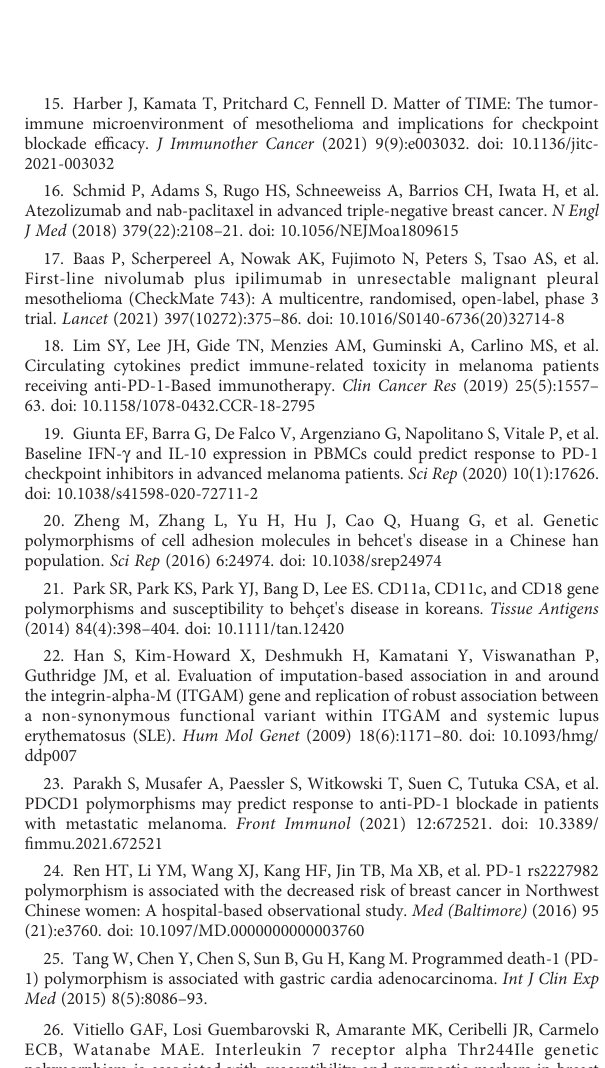
SUPPLEMENTARY TABLE 2 Antibody list for Flow cytometer.